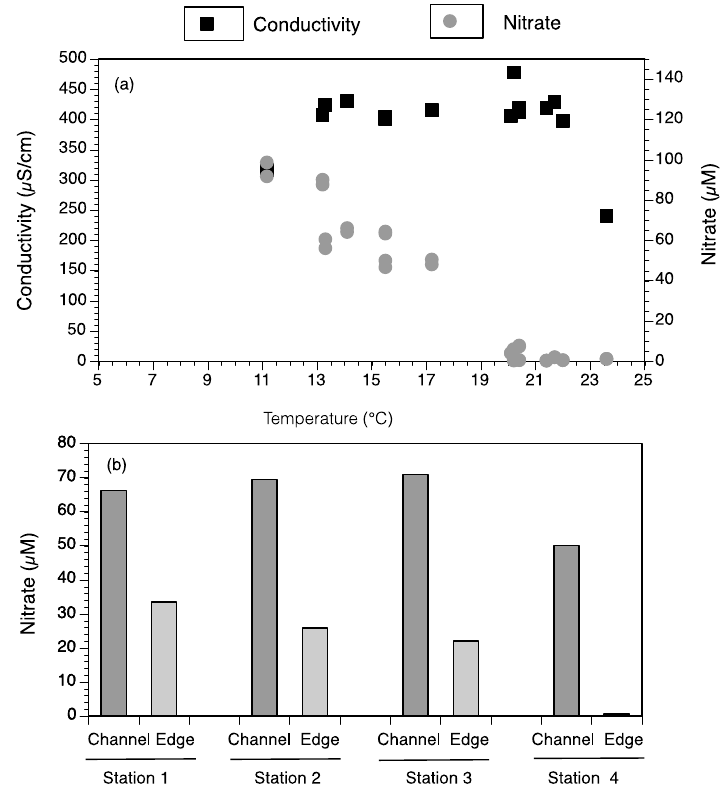
Figure 8. ( a ) Transect of water samples in intertidal wetlands during pulse with change in water temperature with conductivity and nitrate concentration. ( b ) Concentrations of nitrate in water column in channel center (channel) and where water was flowing from marsh into channel (edge). See Figure 2 for specific sampling location for ( a ) and ( b ).